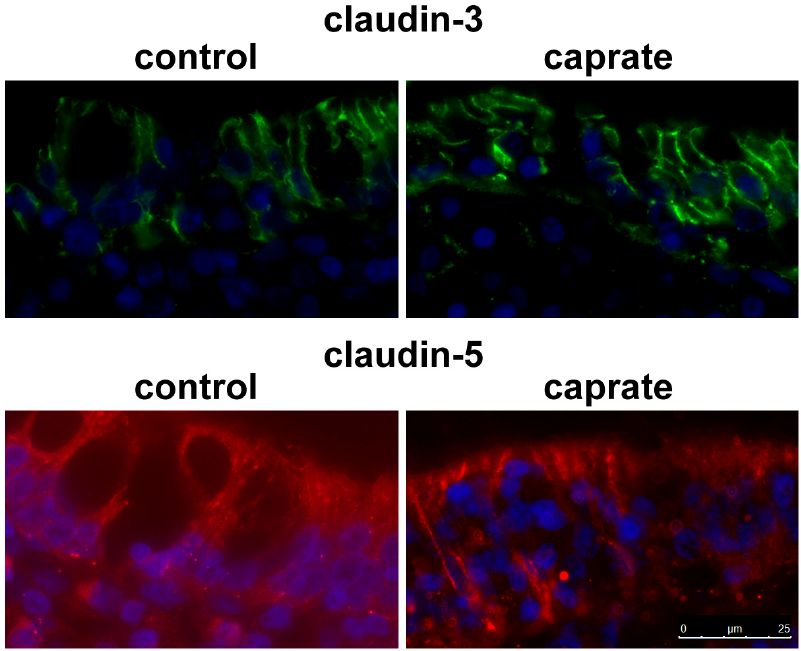
Figure 4. Immunohistochemistry. TJ proteins claudin-3 and claudin-5 are detectable as paracellular signals in the surface epithelium in PP tissue (bar: 25 µm).